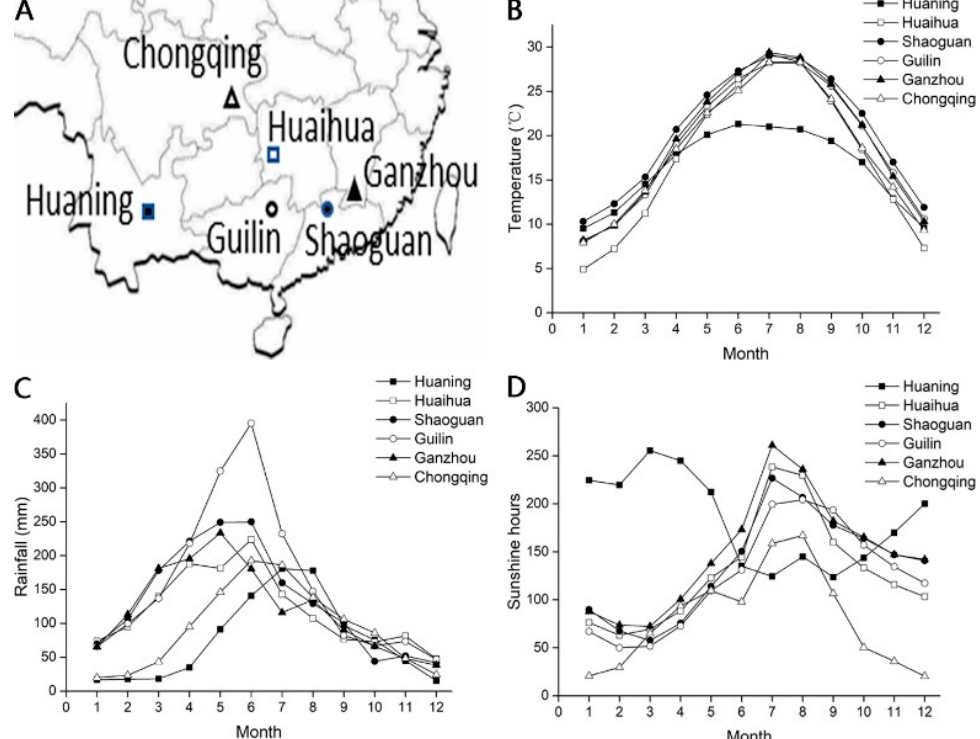
Figure 3. Citrus sinensis ‘bingtangcheng’ collection site environment details. ( A ) map of locations of the six collection sitesacross China, ( B ) Average temperature (°C), ( C ) Average rainfall (mm) and ( D ) Average sunshine duration hours recorded from 1981 to 2010 for Huaning ( ■ ), Huaihua ( □ ), Shaoguan ( ● ), Guilin ( ○ ), Ganzhou ( ▲ ) and Chongqing ( △ ).